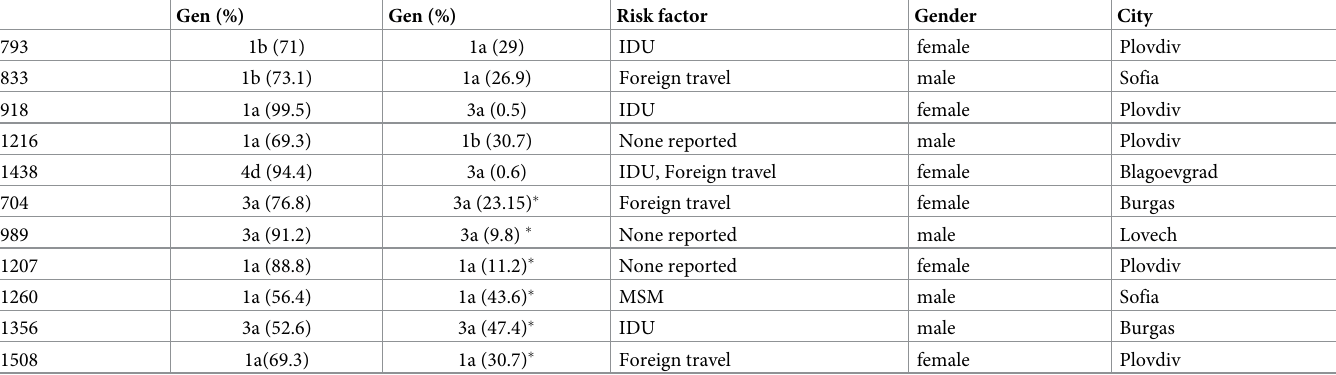
� indicates superinfection with different strain from the same